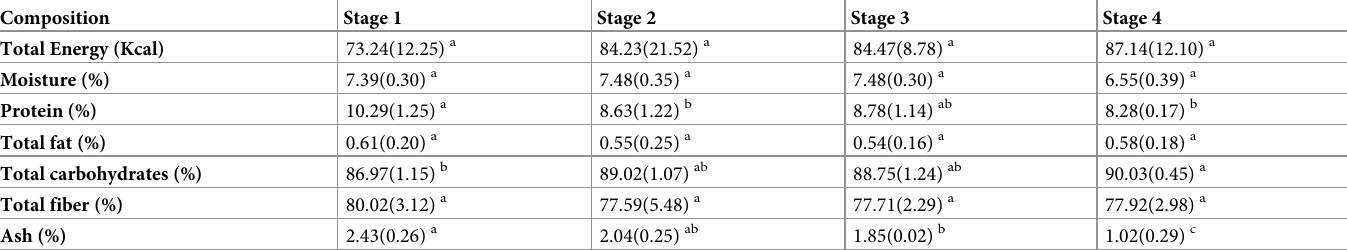
Table 5. Proximate composition of S . madagascariensis seed flour (per 100 g, dry mass basis) at four stages of ripeness. Data presented in the table above represents the mean of five replicates, followed by the standard error. Values associated with the same letter in each row for each location show no significant differences (P <